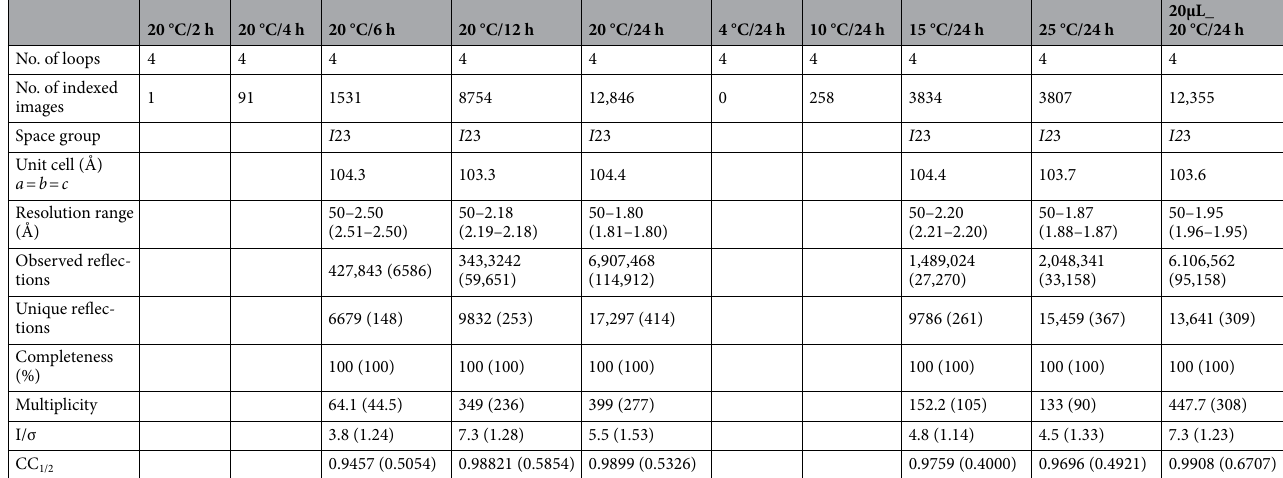
Table 2. Crystallographic data of PhC_CF . Values in parentheses are for the highest-resolution shell.